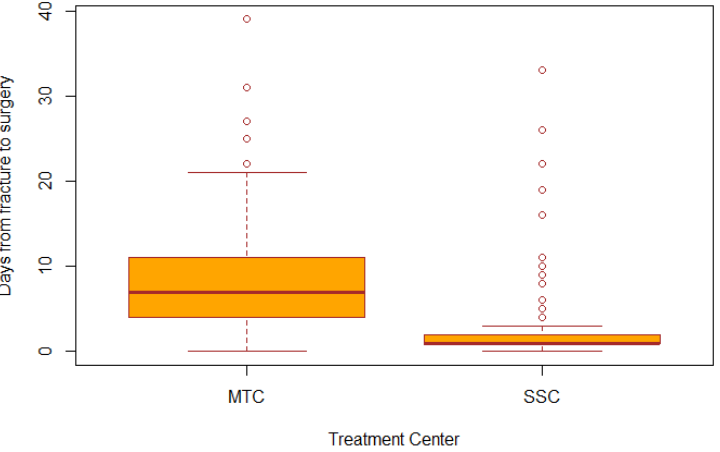
Figure 4. Box plot illustrating median days from fracture to surgery for lesions in the proximal femur. Moods-median-test showed significant difference between MTC and SSC ( p < 0.001).